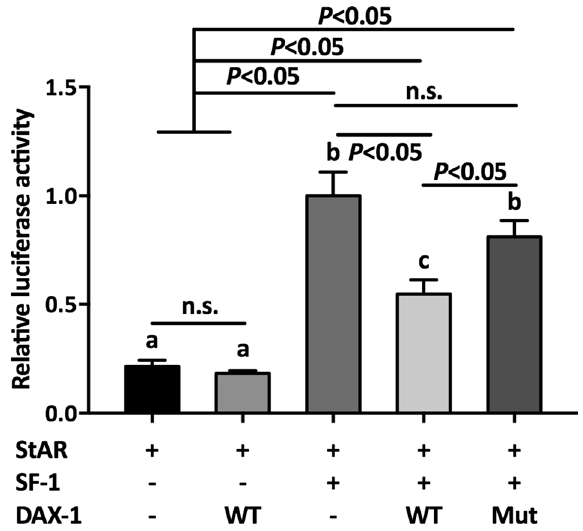
Figure 3. Luciferase assay for SF-1 mediated StAR transactivation in the presence of wild-type or mutant DAX- 1. StAR: Steroidogenic acute regulatory protein, SF-1: Steroidogenic factor 1, WT: Wild-type DAX-1 plasmid, Mut: Mutant DAX-1 plasmid. Error bars represent the standard deviation of triplicate samples. Different lowercase letters represent the significance of differences at P <